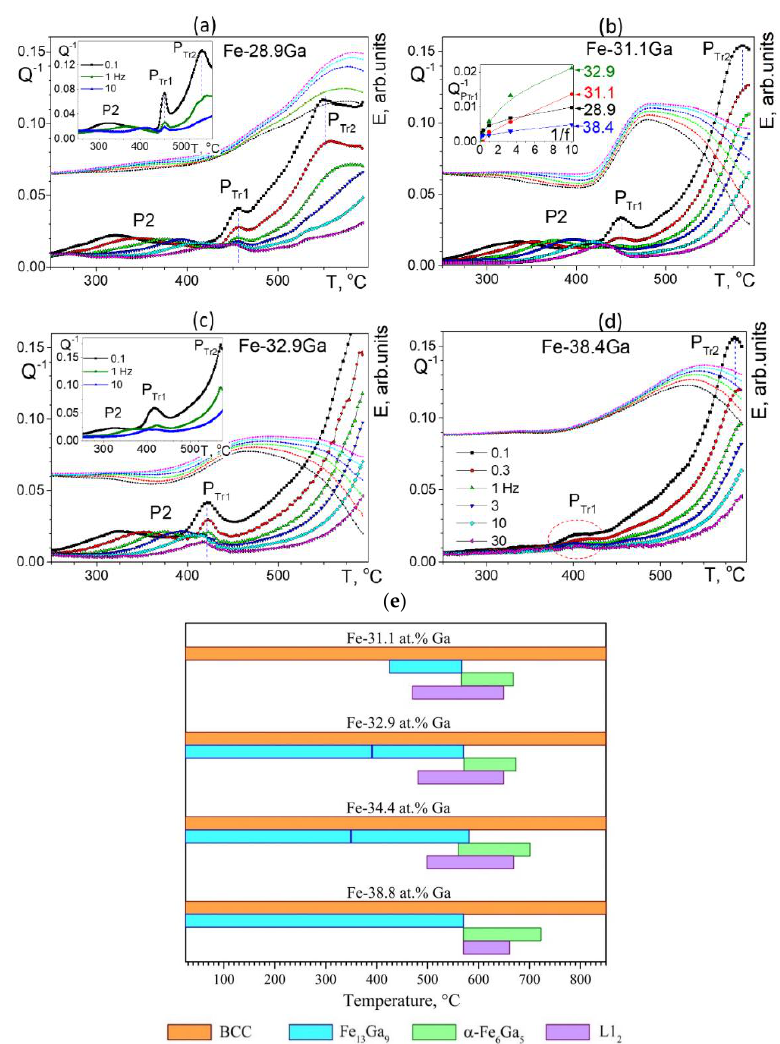
Figure 27. ( a – d ) TDIF curves at heating with K/min rate for the Fe–28.9Ga ( a ), Fe–31.1Ga ( b ), Fe–32.9Ga ( c ), and Fe–38.4Ga ( d ) (insets to ( a , c ): TDIF curves for the water-quenched samples from 800 ◦ C for the alloys Fe–28.9Ga and Fe–32.9Ga. Inset to ( b ): the P Tr1 peak height as a function of inverse frequency in Fe–(29–38)Ga); temperature ranges for the existence of phases during heating up to 850 ◦ C ( e ). The vertical segments indicate the temperatures corresponding to significant increase in the volume fraction of Fe 13 Ga 9 upon heating